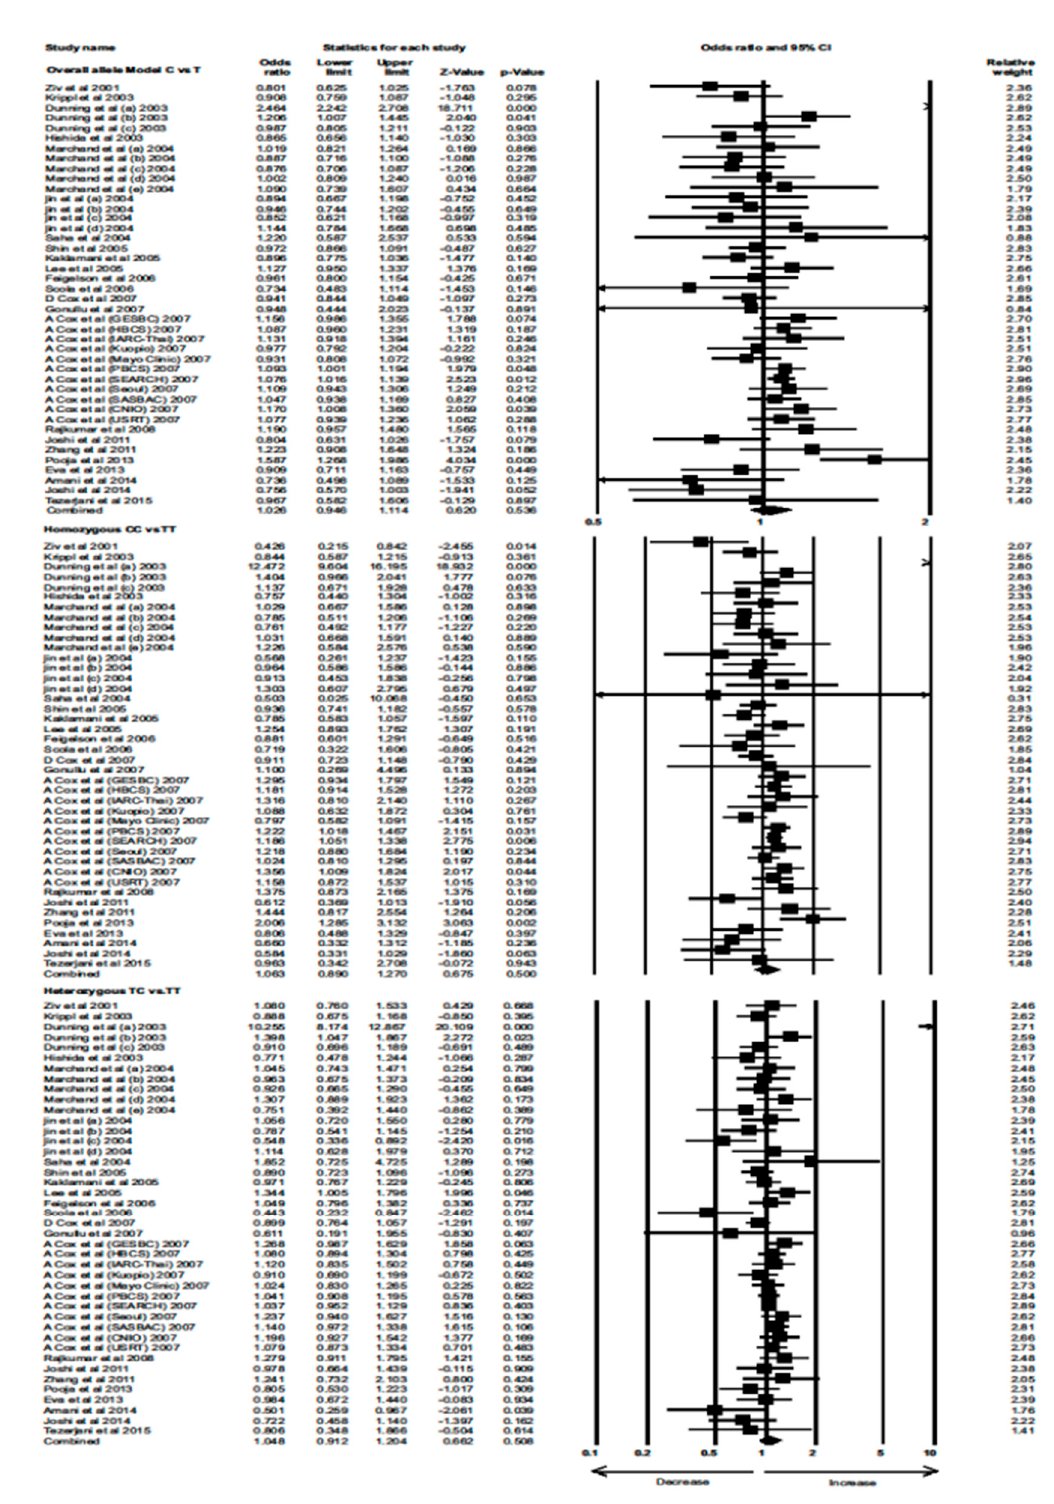
Figure 1. Forest plot of overall allele, homozygous, and heterozygous genotypic analyses of the TGF- β 1 29T > C polymorphism and assessment of its association with BC risk using combined odds ratios (ORs) and 95% confidence intervals (CIs) of the ORs. Black squares represent the ORs of the individual studies, and horizontal lines indicate the 95% CIs of the ORs.